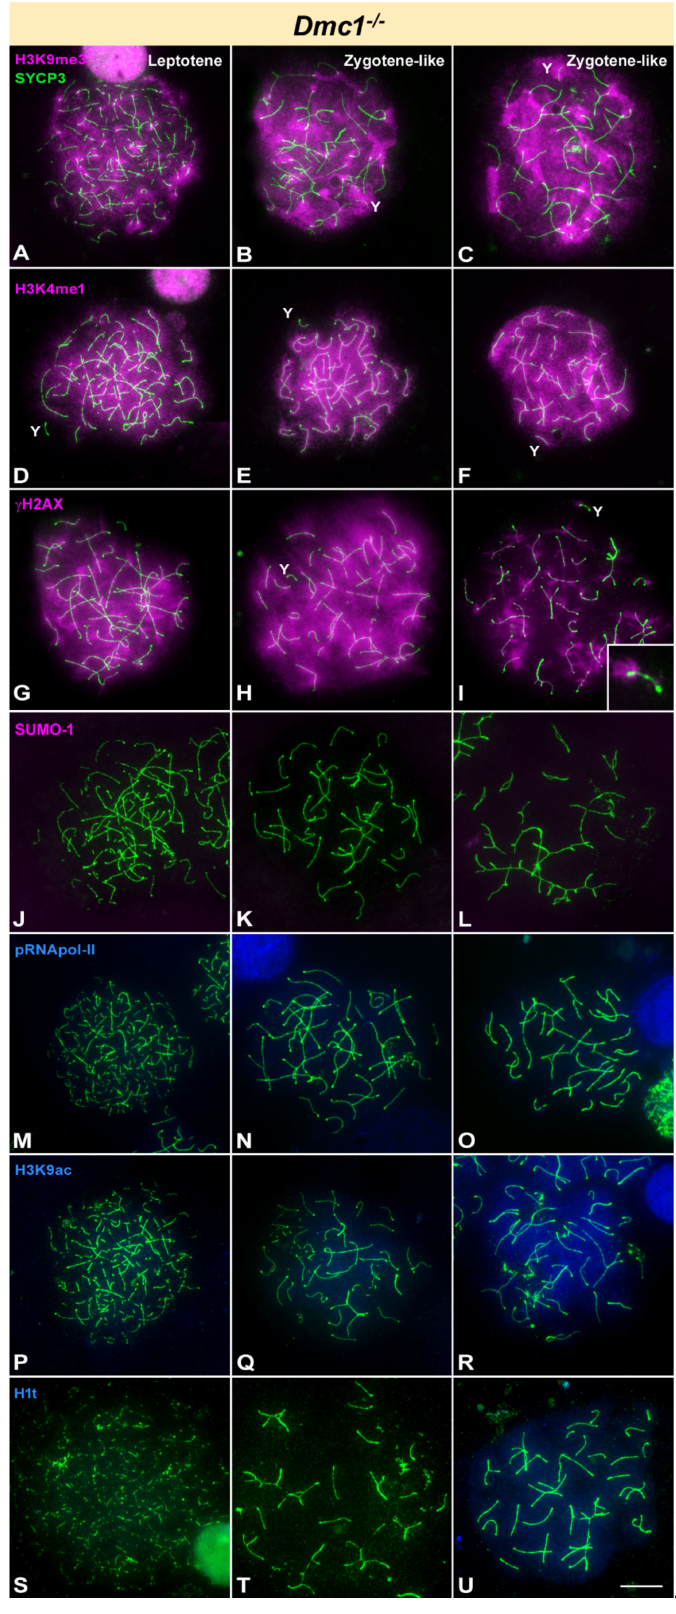
Figure 4. Immunolocalization of SYCP3 (green) and epigenetic markers of silencing (pink) or transcription activation (blue) in Dmc1 knockout mice. Y indicates the Y chromosome, which is identified by its size and morphology of the